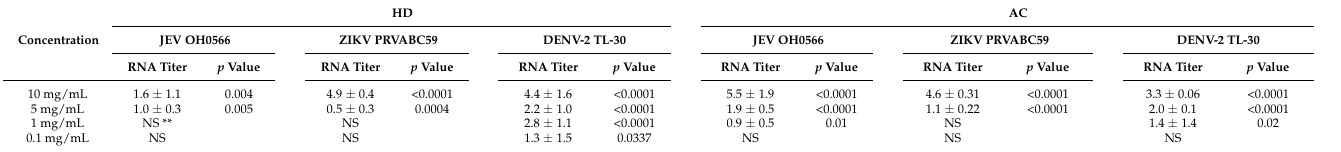
Table 2. Reduction in viral genomic RNA level upon herb treatment at concentrations of 10 and 5